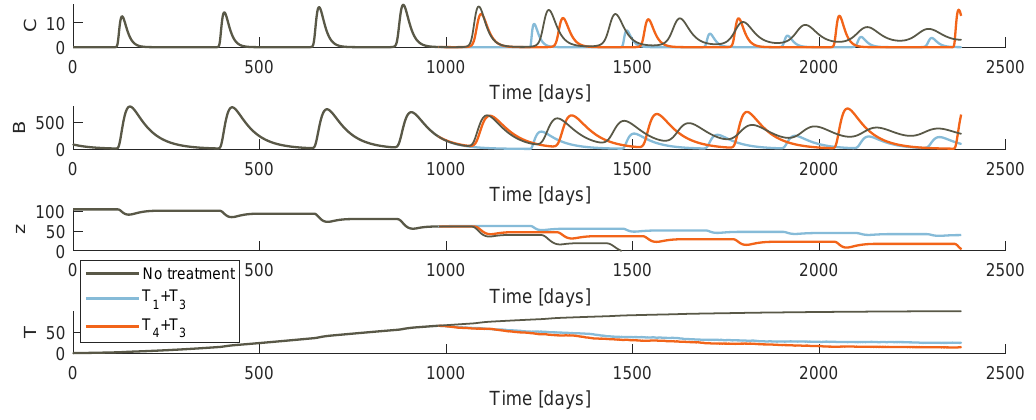
Figure 5. Model M DR 1 behaviour when the tumour arises at t = 0 and the treatment begins at t start = 980 days.